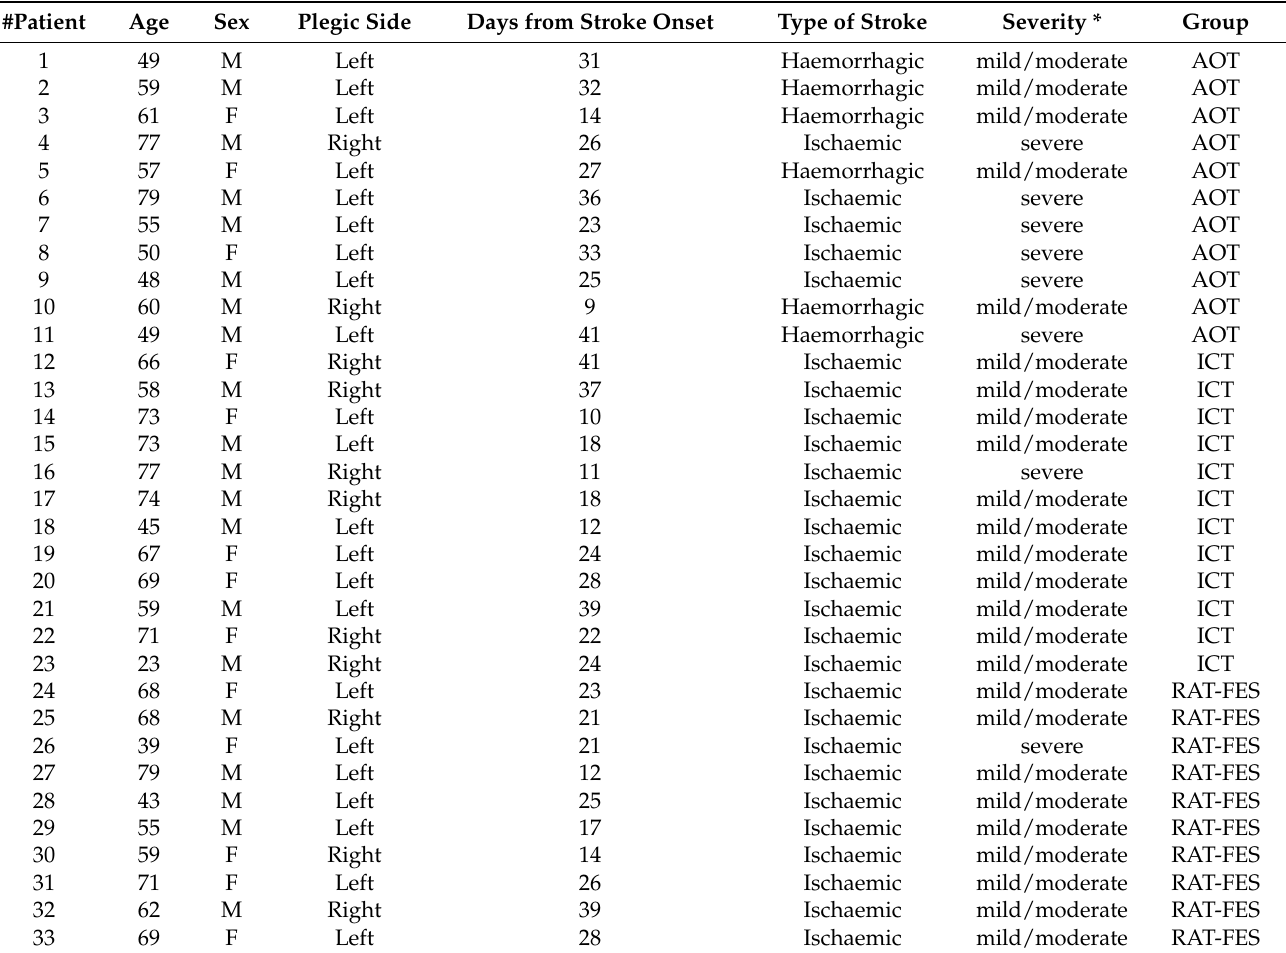
Table 1. Demographic and clinical